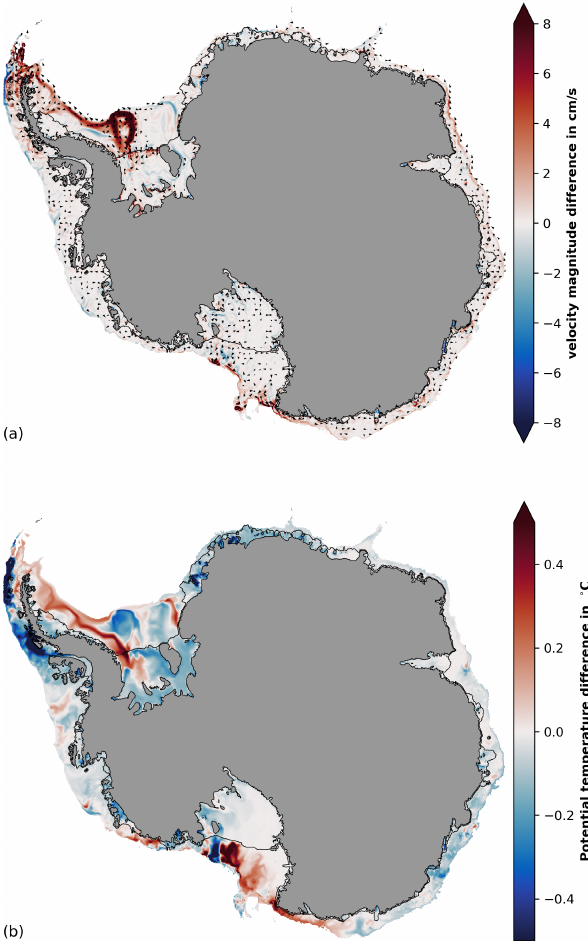
Figure 3. Mean and tidal current speed. (a) Mean barotropic veloc- ities from the simulation with tides. (b) Mean speed of oscillating tidal currents ( | u | tide , calculated following Eq. 1; see Sect. 2.3). Ar- rows in (a) indicate flow direction and are shown only where veloc- ities are stronger than 1cms − 1 .